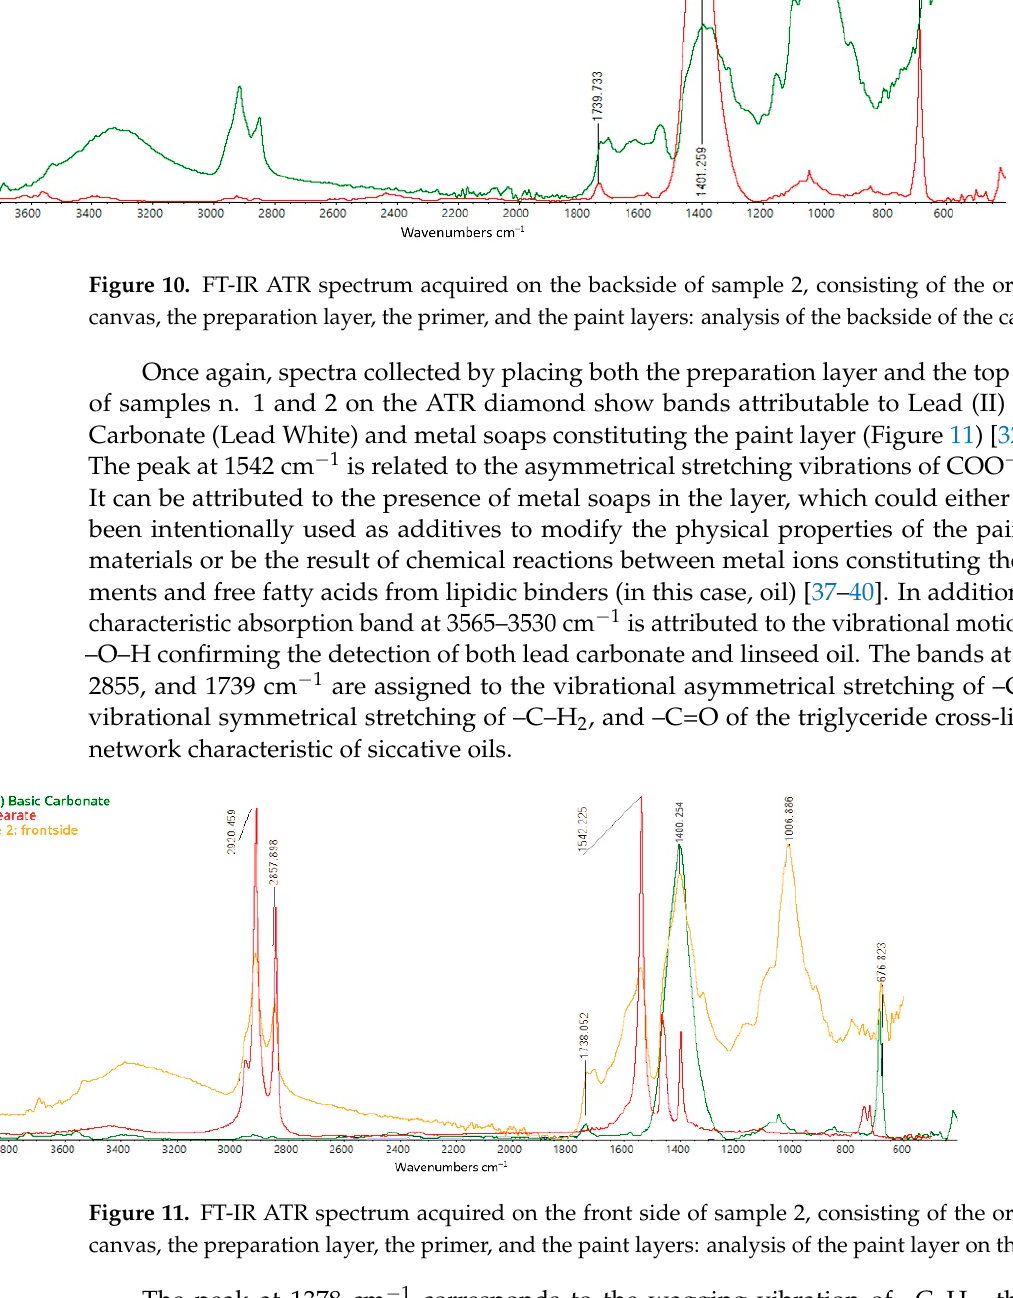
Figure 11. FT-IR ATR spectrum acquired on the front side of sample 2, consisting of the original canvas, the preparation layer, the primer, and the paint layers: analysis of the paint layer on the top.